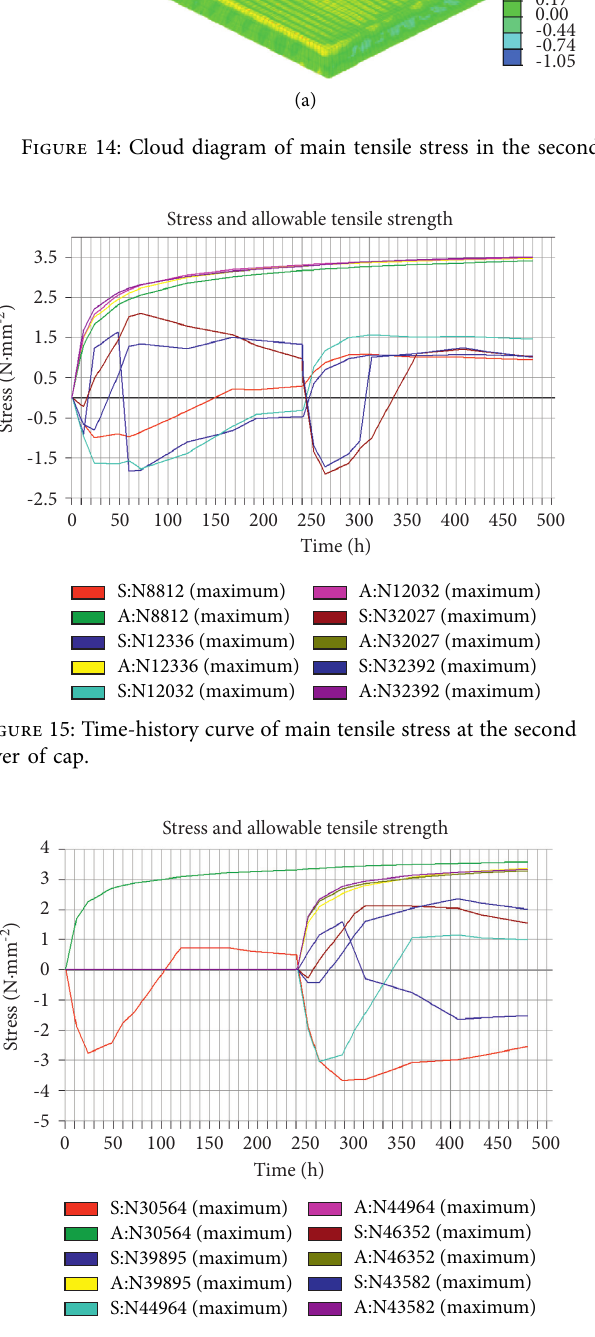
Figure 16: Cloud diagram of main tensile stress of tower (unit: MPa). (a) Heating stage. (b) Cooling stage.